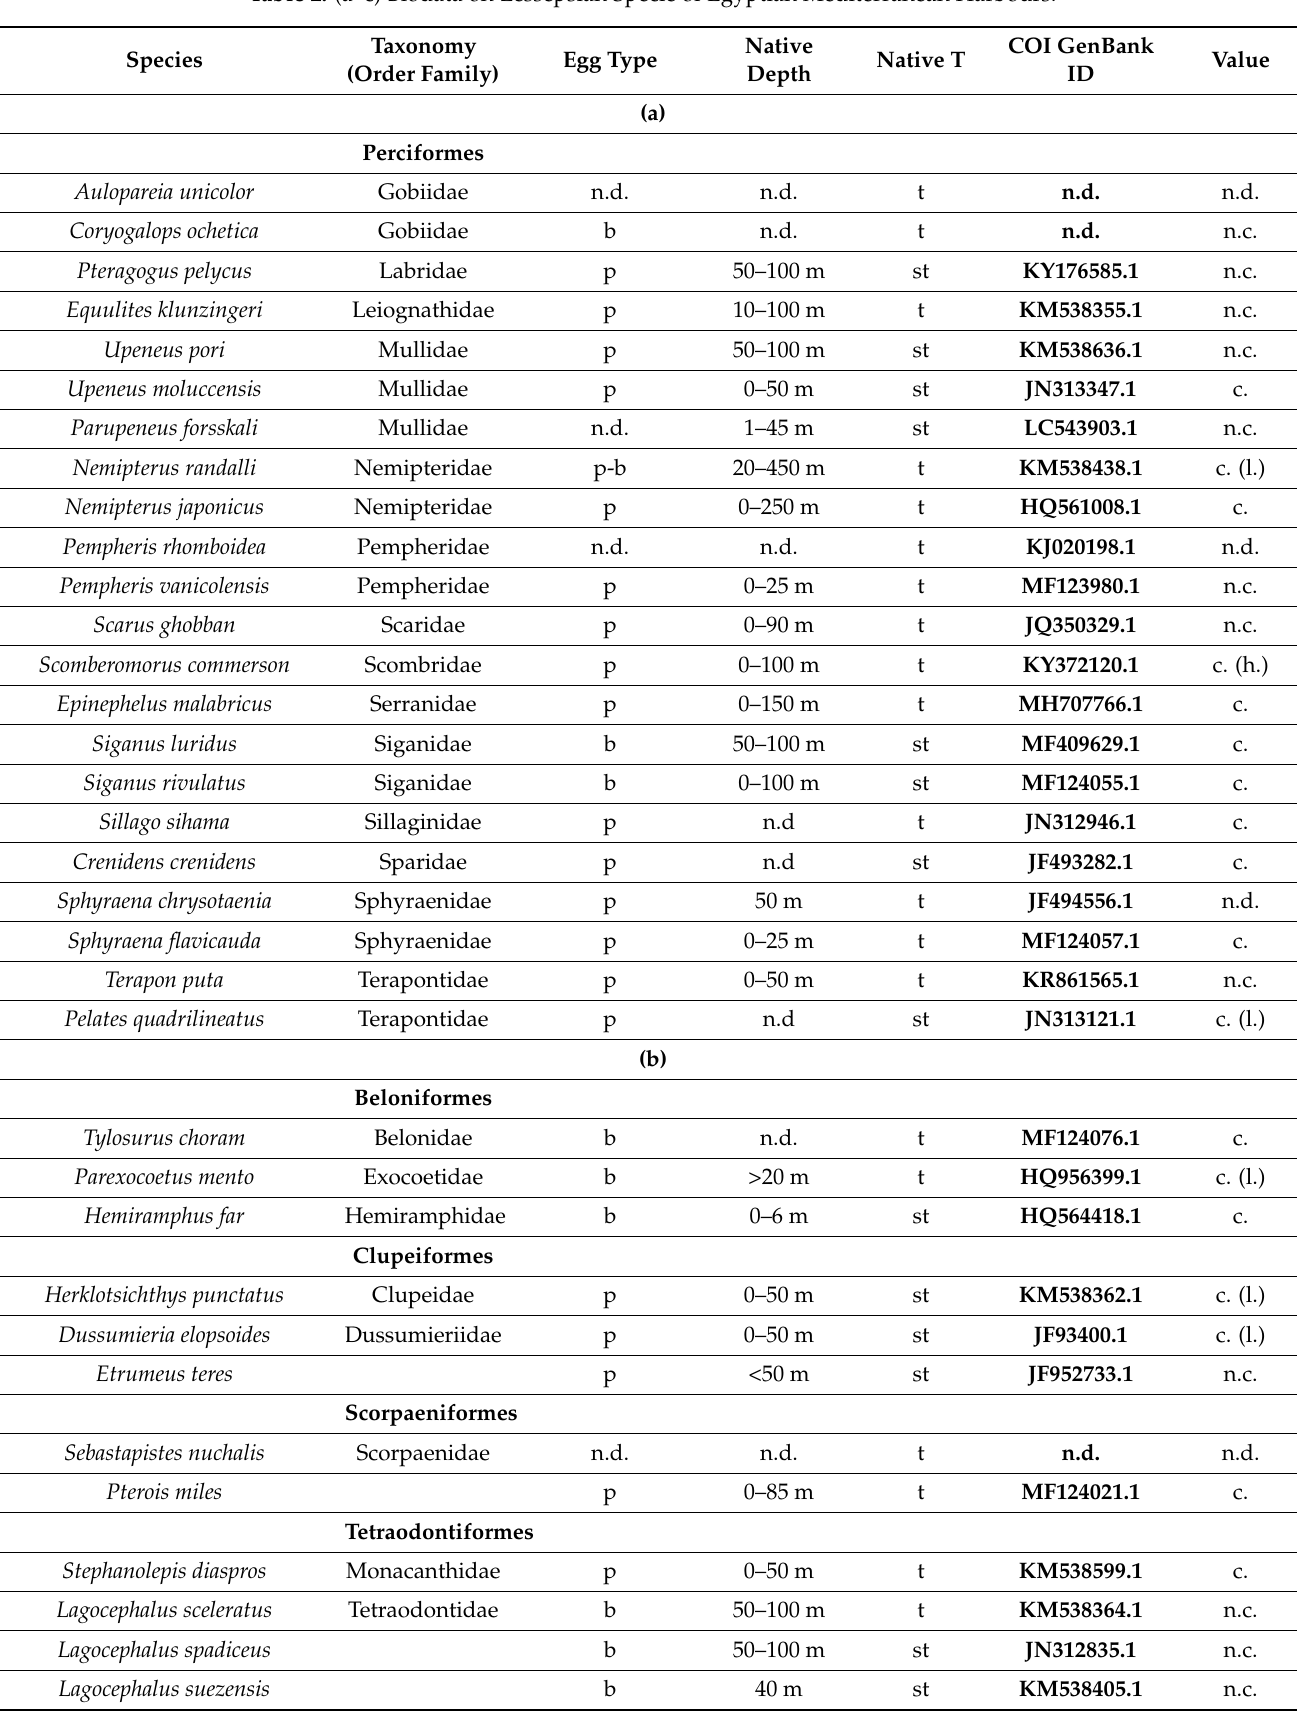
Table 2. (a–c) Biodata on Lessepsian Specie of Egyptian Mediterranean